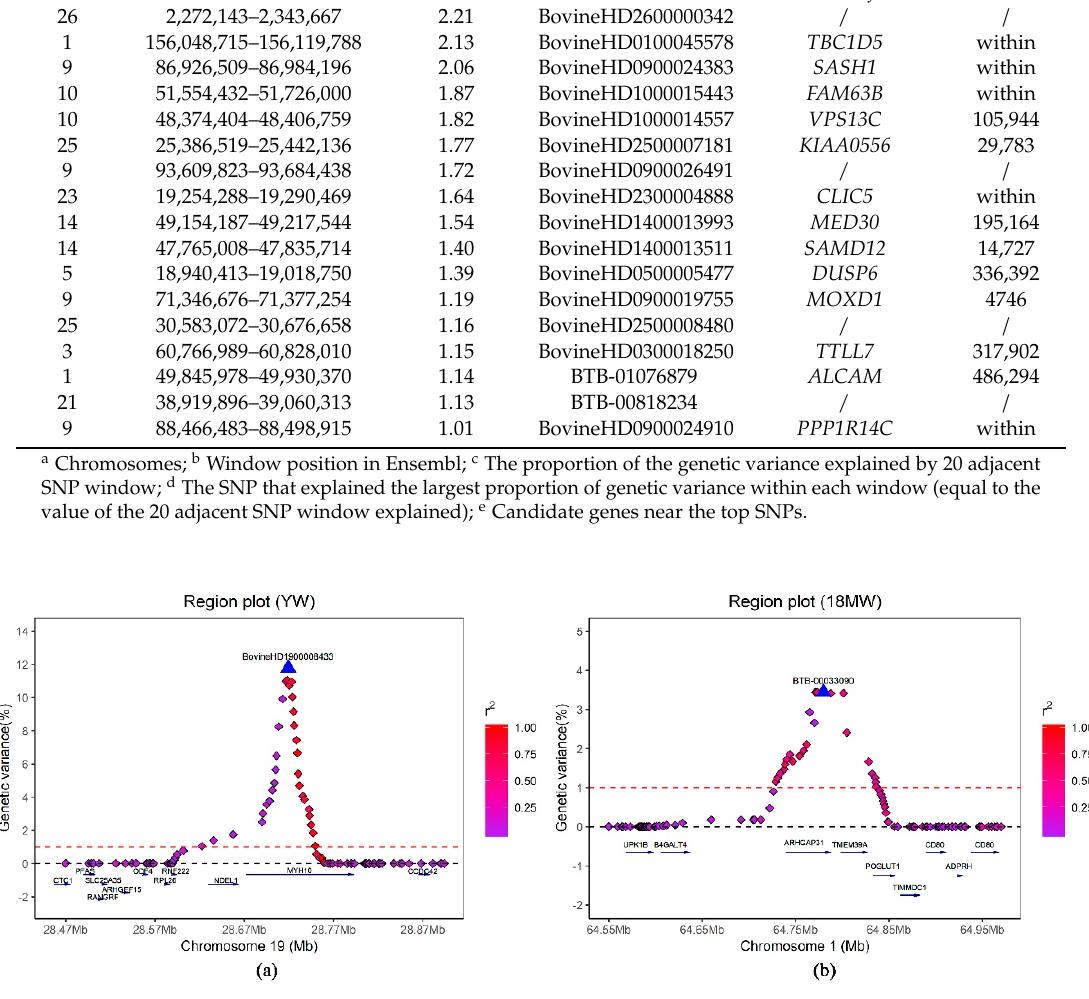
Figure 2. Region plots of the two major candidate regions on BTA19 and BTA1. Results were shown for YW around 28.47–28.90 Mb on BTA19 ( a ) and for 18MW at 64.55–64.98 Mb on BTA1 ( b ). The primary SNP within each region is denoted by a large blue triangle. Different levels of linkage disequilibrium between the primary SNP and surrounding SNPs were represented by colored rhombi.